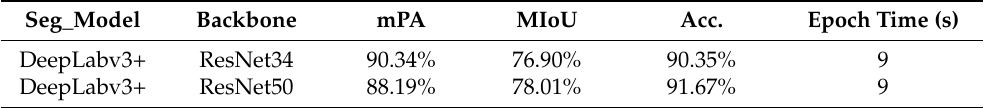
Table 3. Horizontal comparison experiment